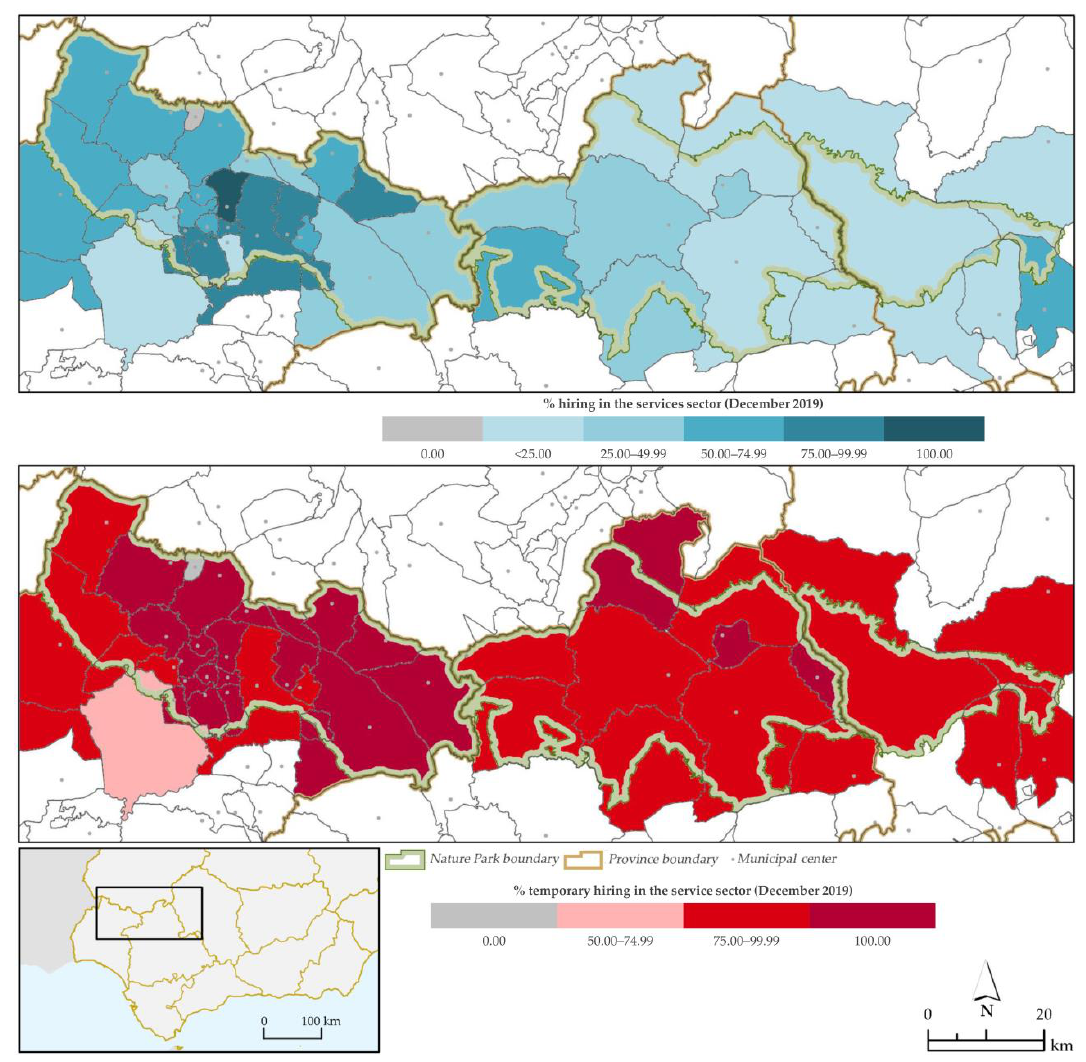
Figure 13. Hiring (upper map) and temporary employment (lower map) in the services sector (December 2019). Source: [126]; authors ’ elaboration.